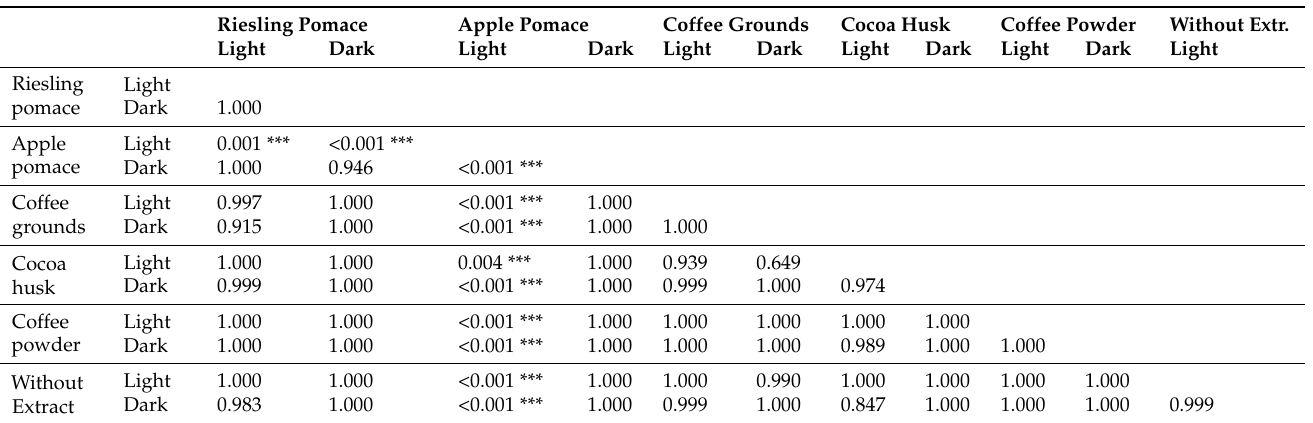
Figure 6. Correlation between daily oxygen consumption rate and antioxidant activity of emulsions with plant extracts. The figure shows the daily oxygen consumption rate in mg O 2 per 100 g per day as a function of the antioxidant activity in AUC/% dry mass measured with ORAC assay, as mean values ( n = 3) with exponential equalization function (R 2 = 0.84) for all samples stored in light. Table 5. p -Values of all pairwise multiple comparison procedures (Holm–Šid á k method) of the